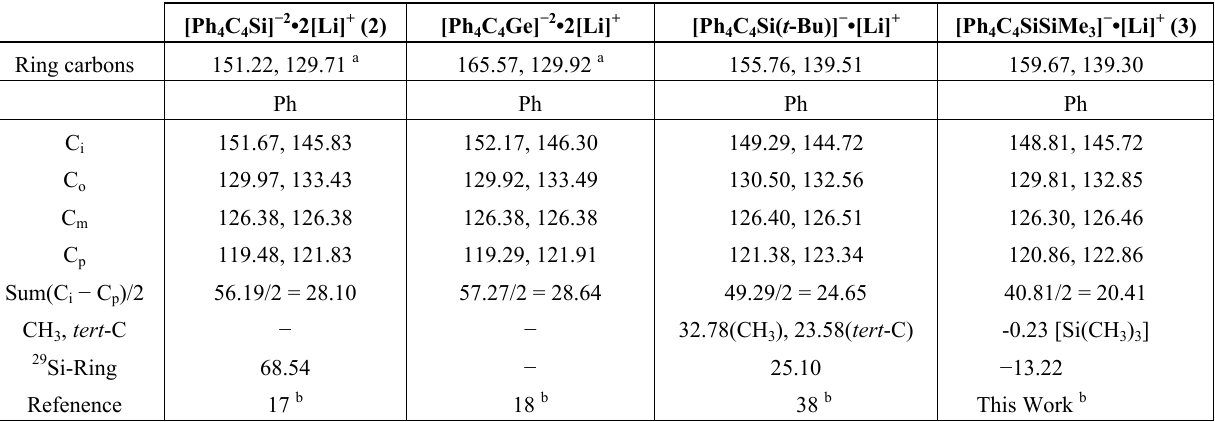
Table 2. 13 C/ 29 Si-NMR chemical shifts of silole/germole dianions and silole